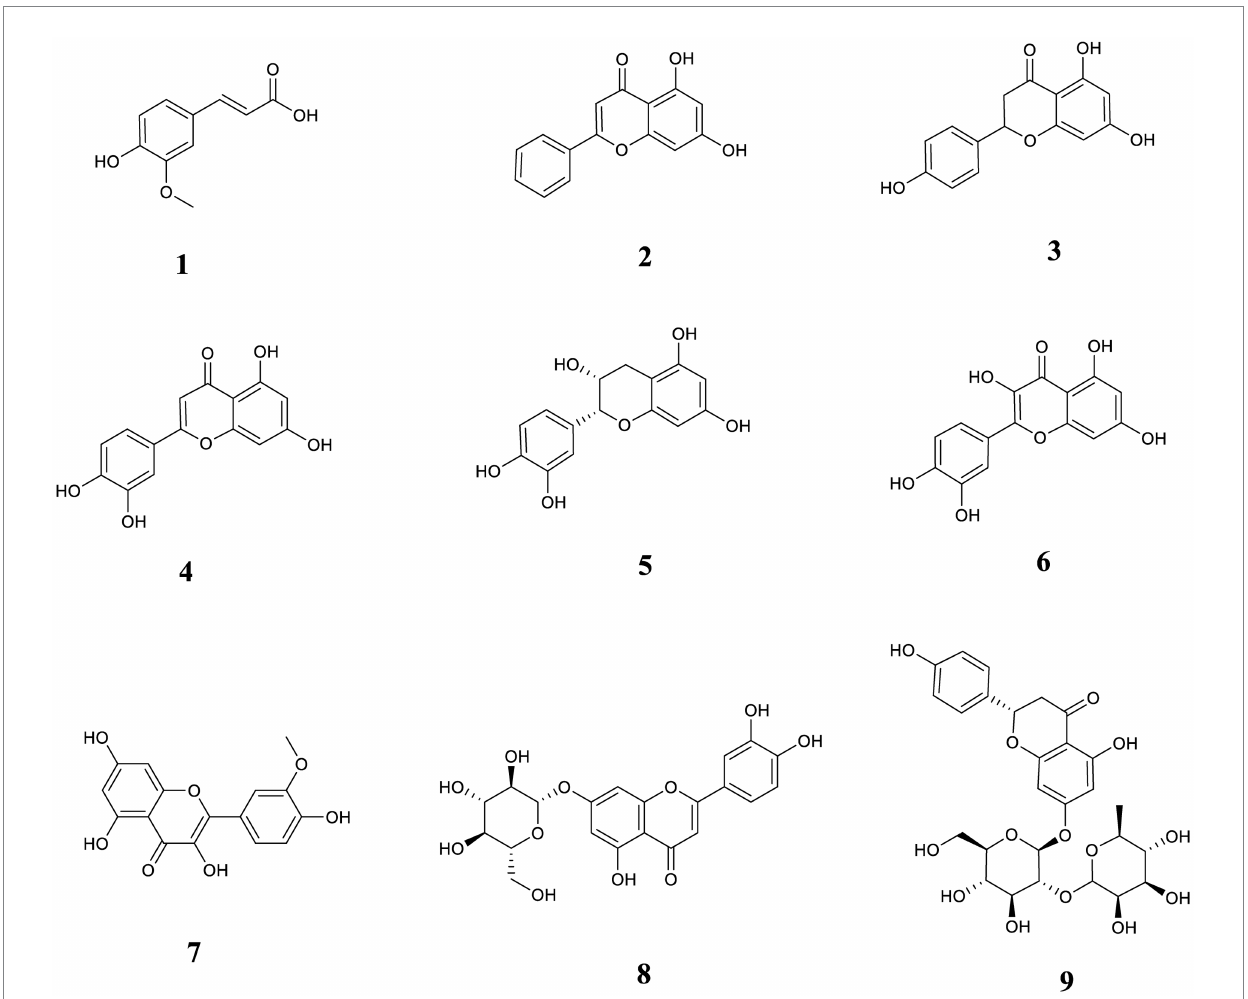
FIGURE 1 The chemical structures of nine phenolic components in this study. (1) ferulic acid; (2) chrysin; (3) naringenin; (4) luteolin; (5) L-epicatechin; (6) quercetin; (7) isorhamnetin; (8) cynaroside; (9)